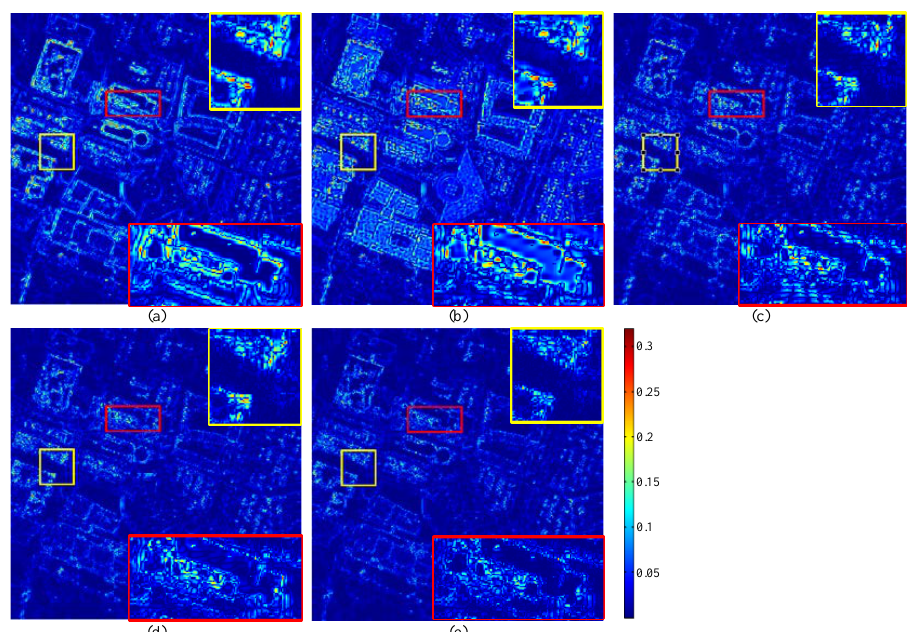
Figure 11. The residual maps on Houston University by an upscaling factor of four. ( a ) Bicubic result, ( b ) SSG result [27], ( c ) SRCNN result [40], ( d ) 3D-CNN result [32], and ( e ) the proposed MW-3D-CNN result. The residual maps are displayed by scaling to the minimum and maximum errors.